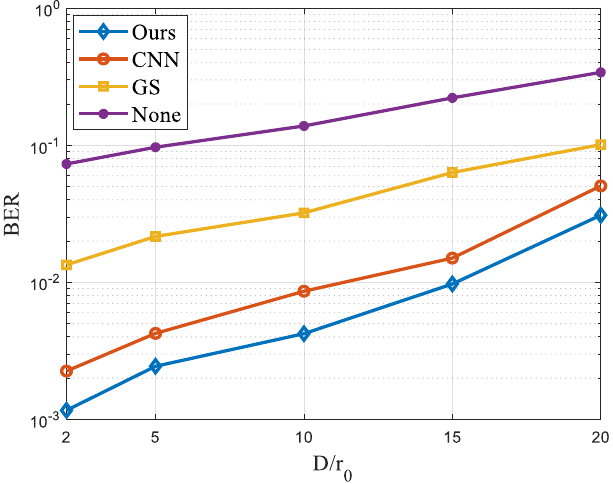
Figure 8. Comparison of BER of the system with different compensation methods.